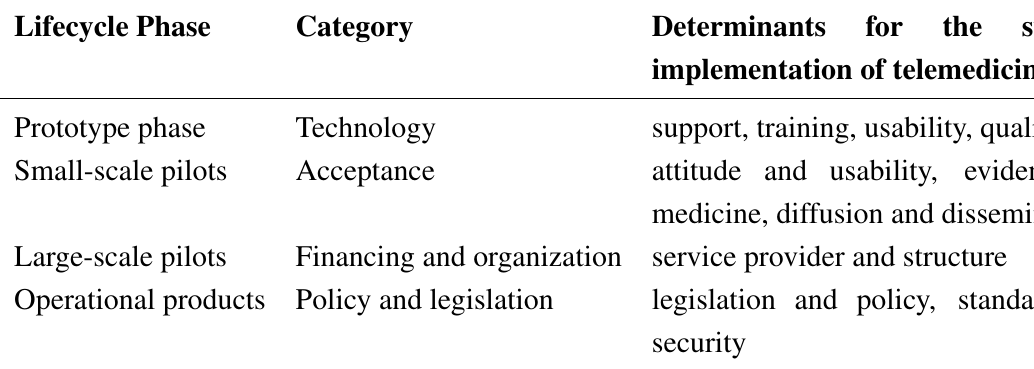
Table 6. The Layered Telemedicine Implementation Model Broens et al.